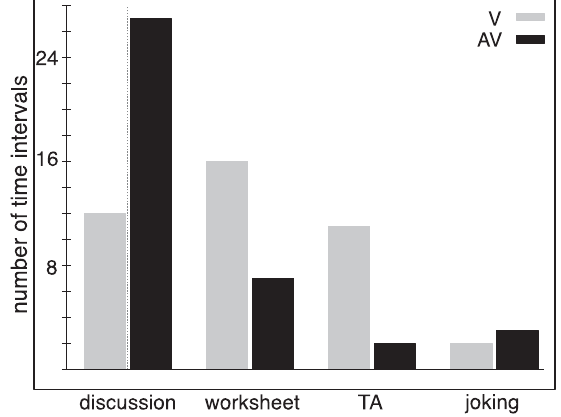
FIG. 3. No-consensus disagreements. No-consensus disagree- ments occur when one mode has consensus in a time interval when the other mode does not have consensus. The bars show the number of time intervals that the mode showing consensus agreed on a particular code when the other mode did not have consensus. Both the worksheet and discussion bar pairs show that the AV mode is slightly biased toward the discussion code while the V mode is slightly biased toward the worksheet code. Also, the V mode is slightly biased toward the instructor code when behavior is ambiguous in the AV